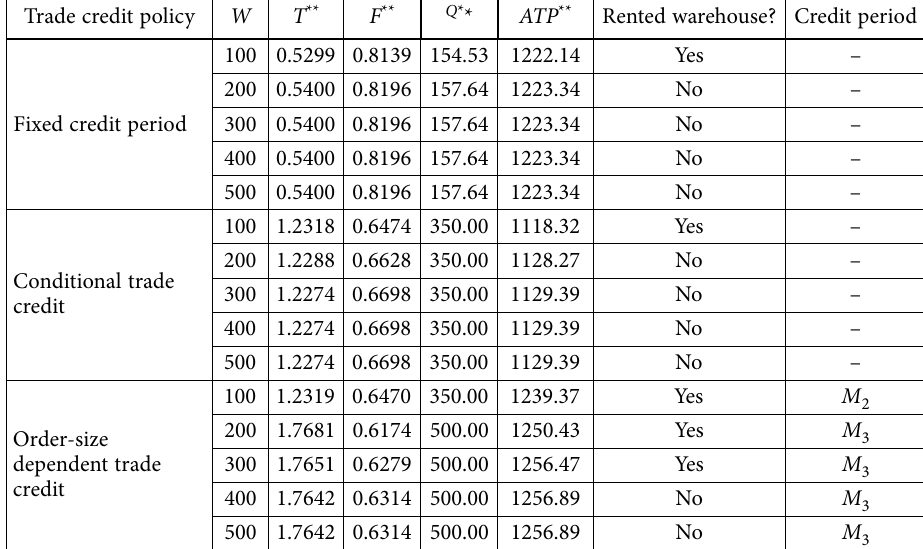
Table 5. The value of order-size dependent trade credit policy Trade credit